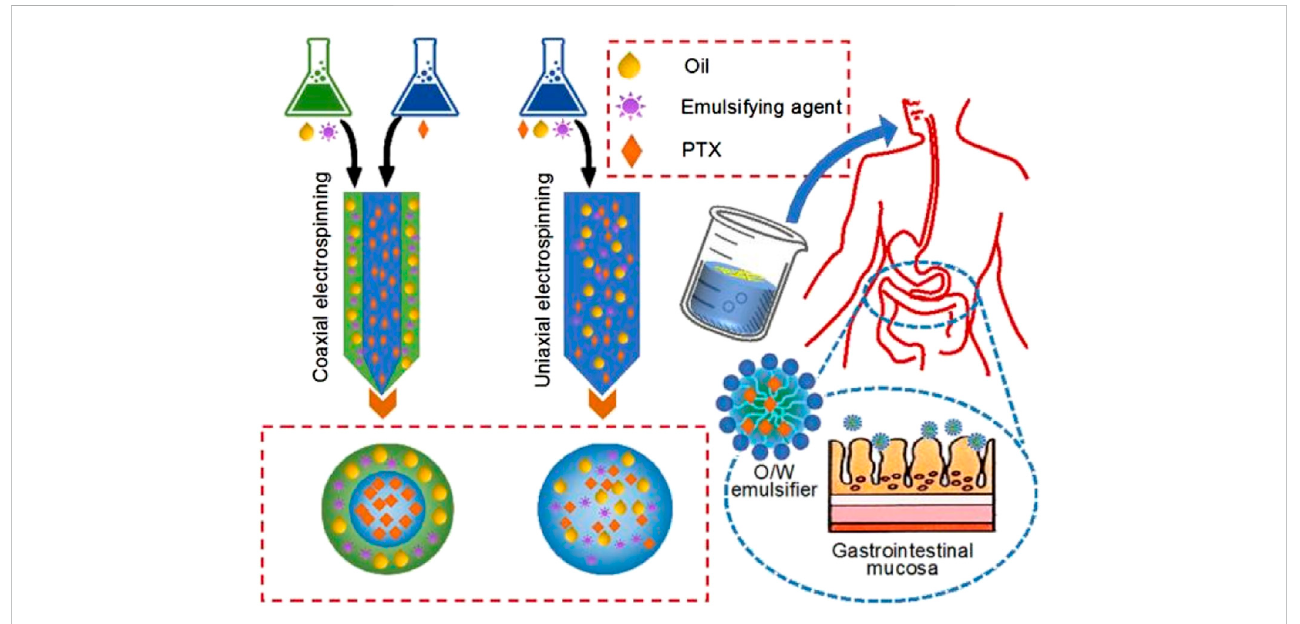
FIGURE 2 Two strategies from electrospun nano fi bers for acting as self-emulsifying drug delivery